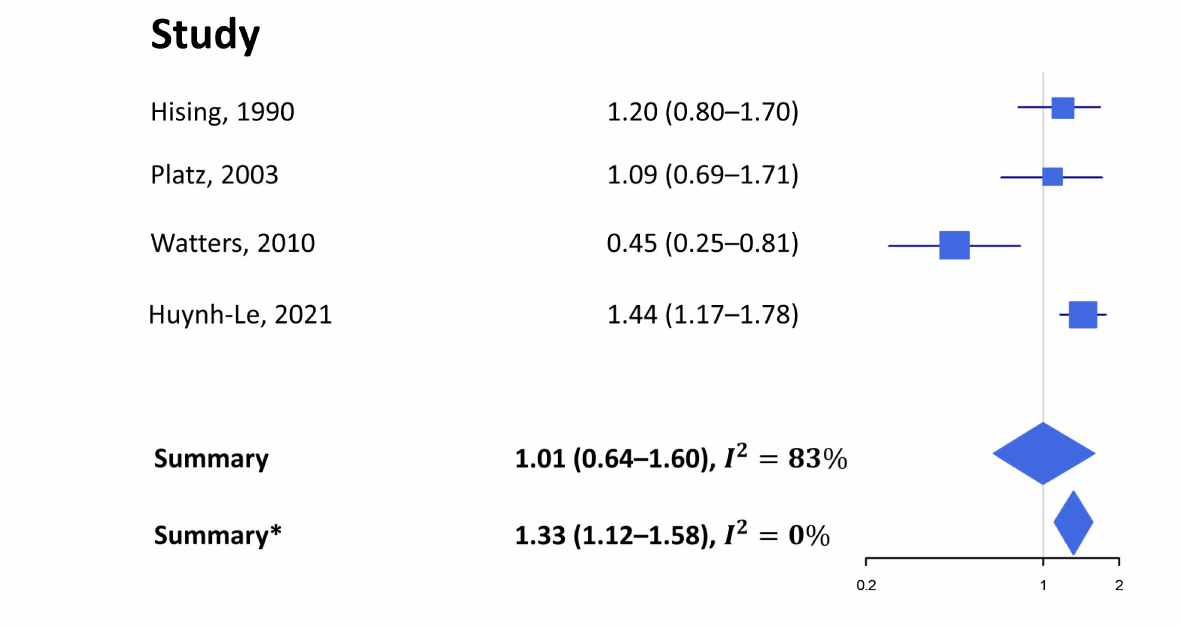
Figure 2. Forest plot of the measures of association between alcohol intake (highest vs. lowest category) and the risk of fatal prostate cancer